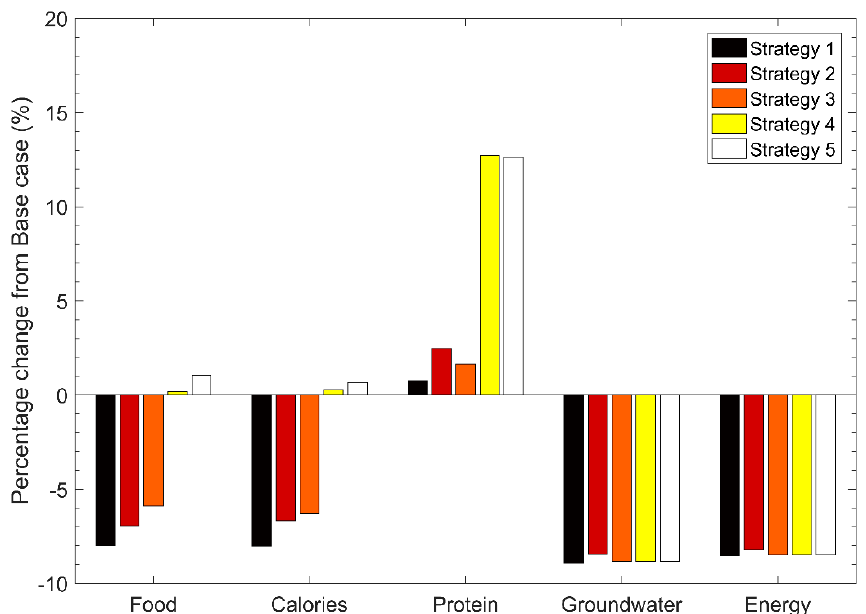
Figure 2. Impact of crop diversification in Scenario B (strategy 5) as compared to Scenario A (base case). In the plot, positive values indicate an increase in the given attribute as compared to the base case and vice versa.